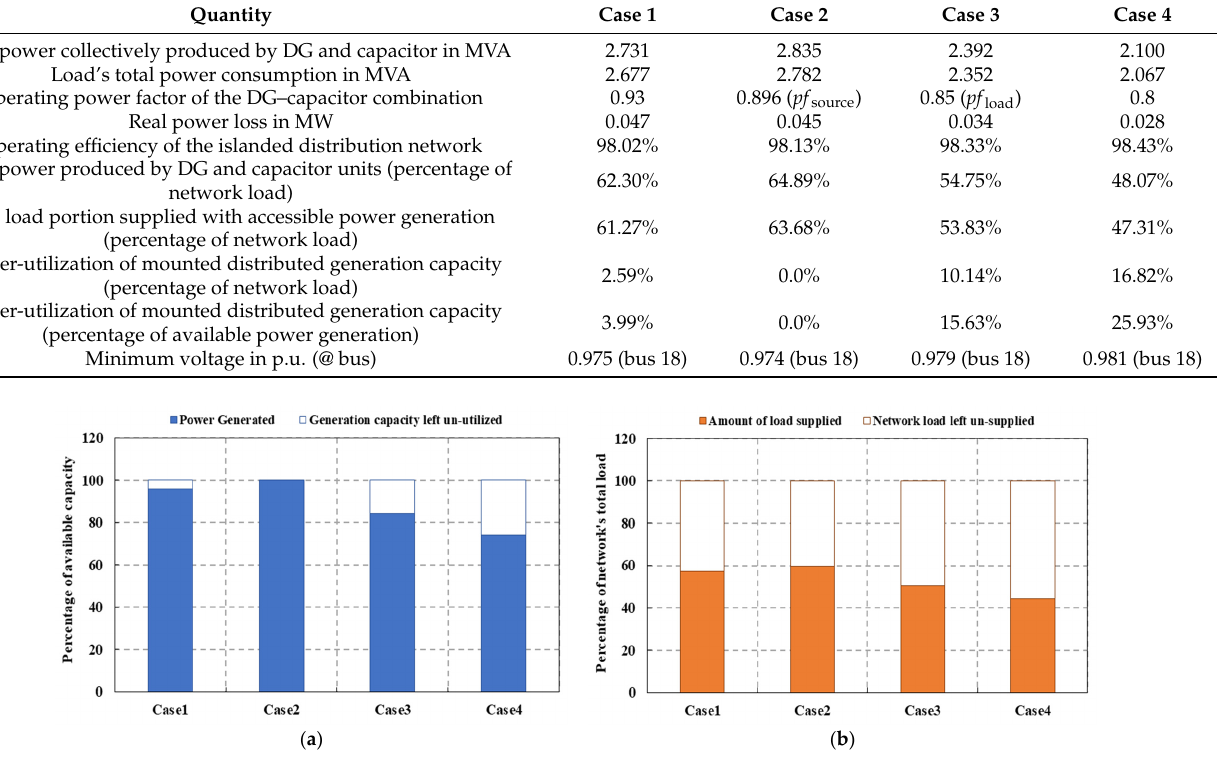
Figure 7. Performance comparison of the 33-bus autonomous distribution network at different pfsource. ( a ) Installed power generation capacity’s % utilization and ( b ) network’s % load share delivered with accessible power.